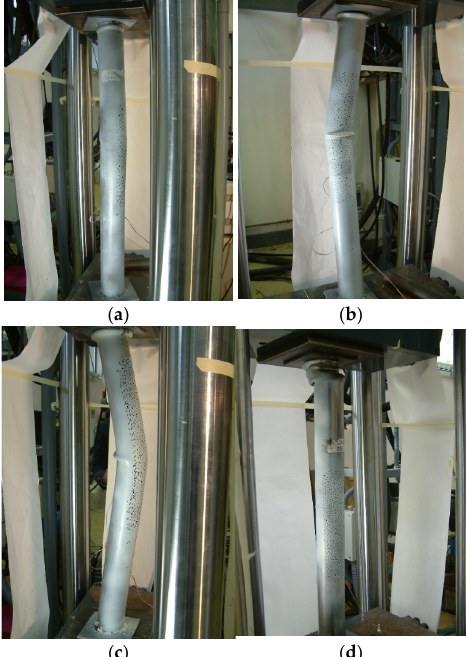
Figure 9. State if hybrid tubes at the end of the test and the cycle in which the state is produced. Core filler materials: ( a ) Polyurethane foam–e lement with a polyurethane foam core, buckling filler materials: ( a ) Polyurethane foam–element with a polyurethane foam core, buckling in cycle 1, in cycle 1 , ( b ) Elastopack-201– element with Elastopack-201 core, buckling in cycle 2 , ( c ) Mul- titek– element with a Multitek core, buckling in cycle 2 , and ( d ) Mortar (SikaGrout-295)– Ele- ( b ) Elastopack-201–element with Elastopack-201 core, buckling in cycle 2, ( c ) Multitek–element with ment with SikaGrout-295 core, no loss of stability due to buckling . a Multitek core, buckling in cycle 2, and ( d ) Mortar (SikaGrout-295)–Element with SikaGrout-295 core, no loss of stability due to